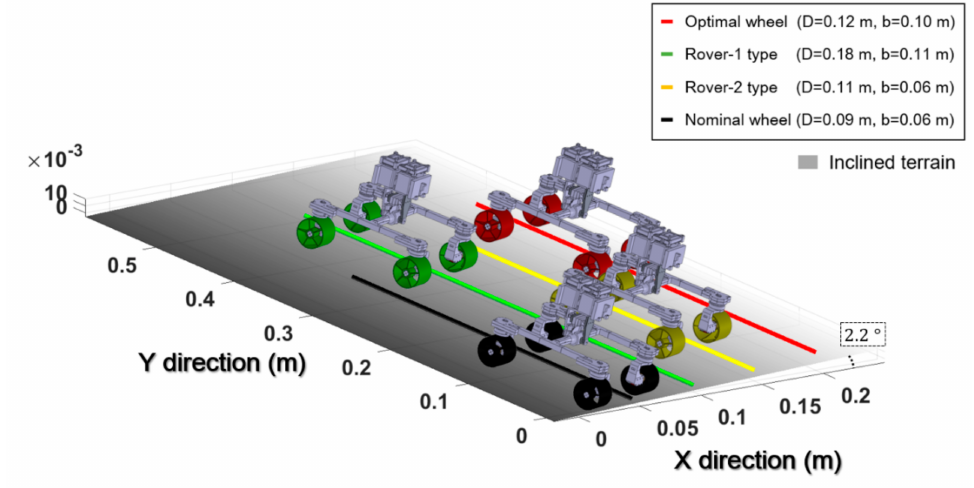
Figure 17. Illustration of paths for various rover testbed models, where each rover travels 2.2 ◦ side slope in the case of landing site at 44.12 ◦